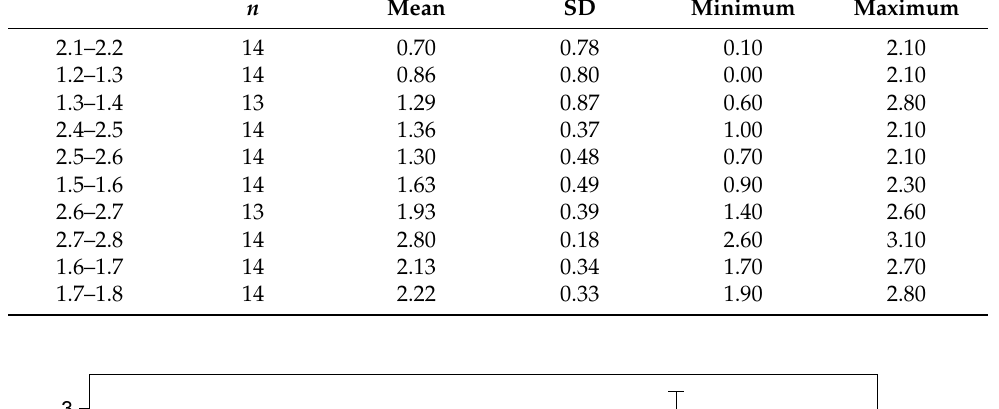
Table 5. Descriptive deviation values at apical end-point (mm) of the orthodontic micro-screws placed in the selected tooth positioning.